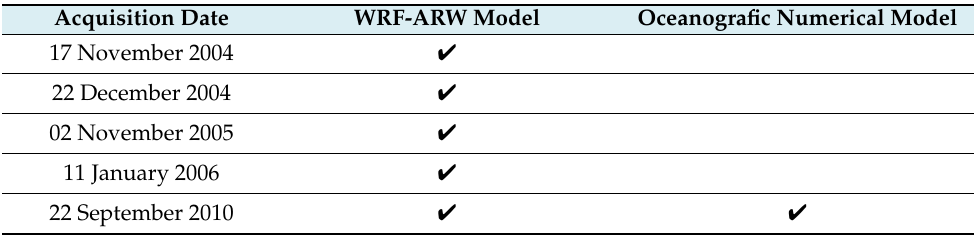
Table 1. Acquisitions dates and used